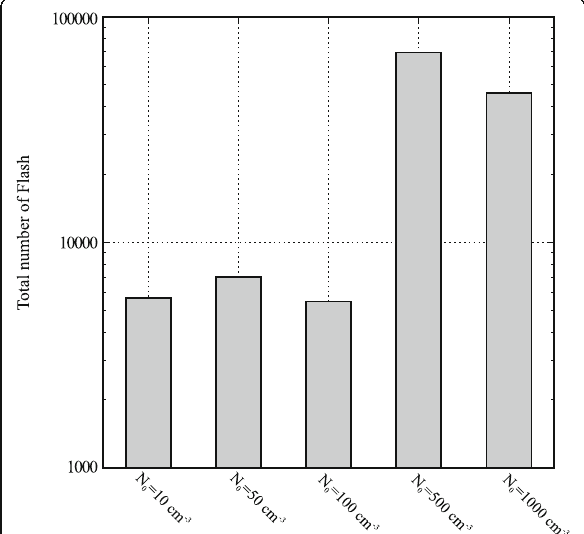
Fig. 9 Total number of lightning flashes accumulated during the last 36 h of the simulation with a parameter sweep of N